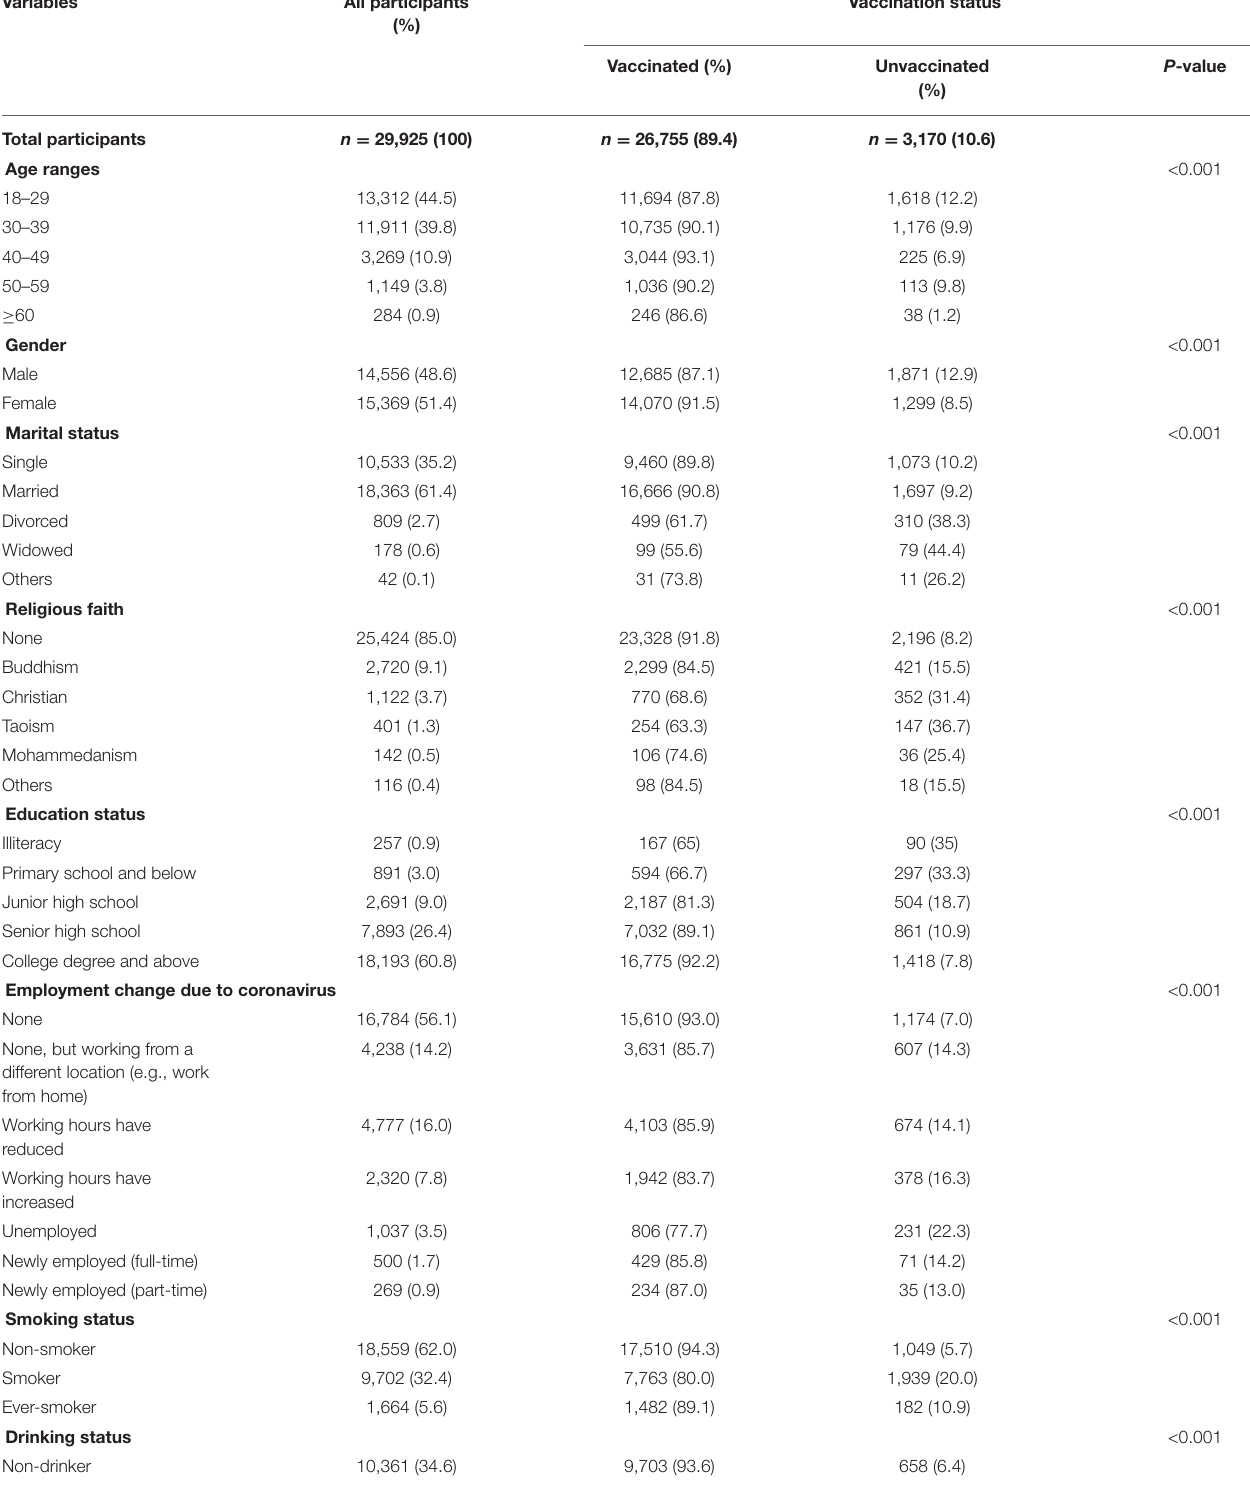
TABLE 1 | Socio-demographic, awareness of COVID-19 pandemic, awareness of COVID-19 vaccine and COVID-19 vaccination rate information ( n = 29,925). Variables All participants Vaccination status (%) Vaccinated